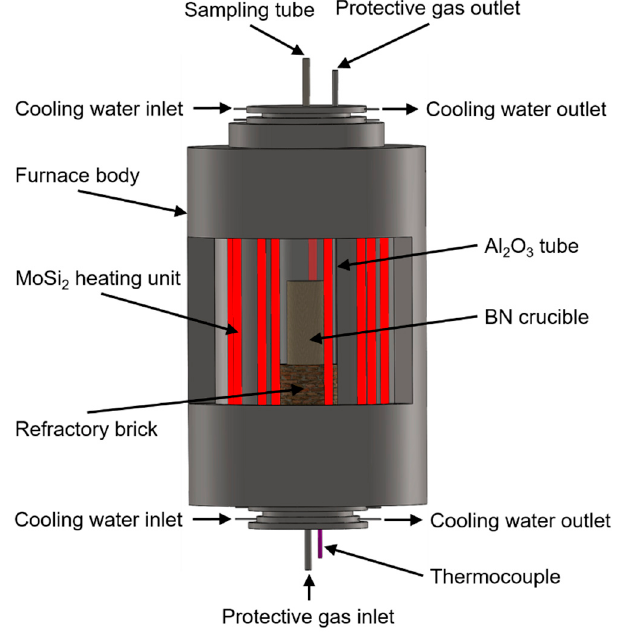
Figure 2. Schematic diagram of the experimental set-up.